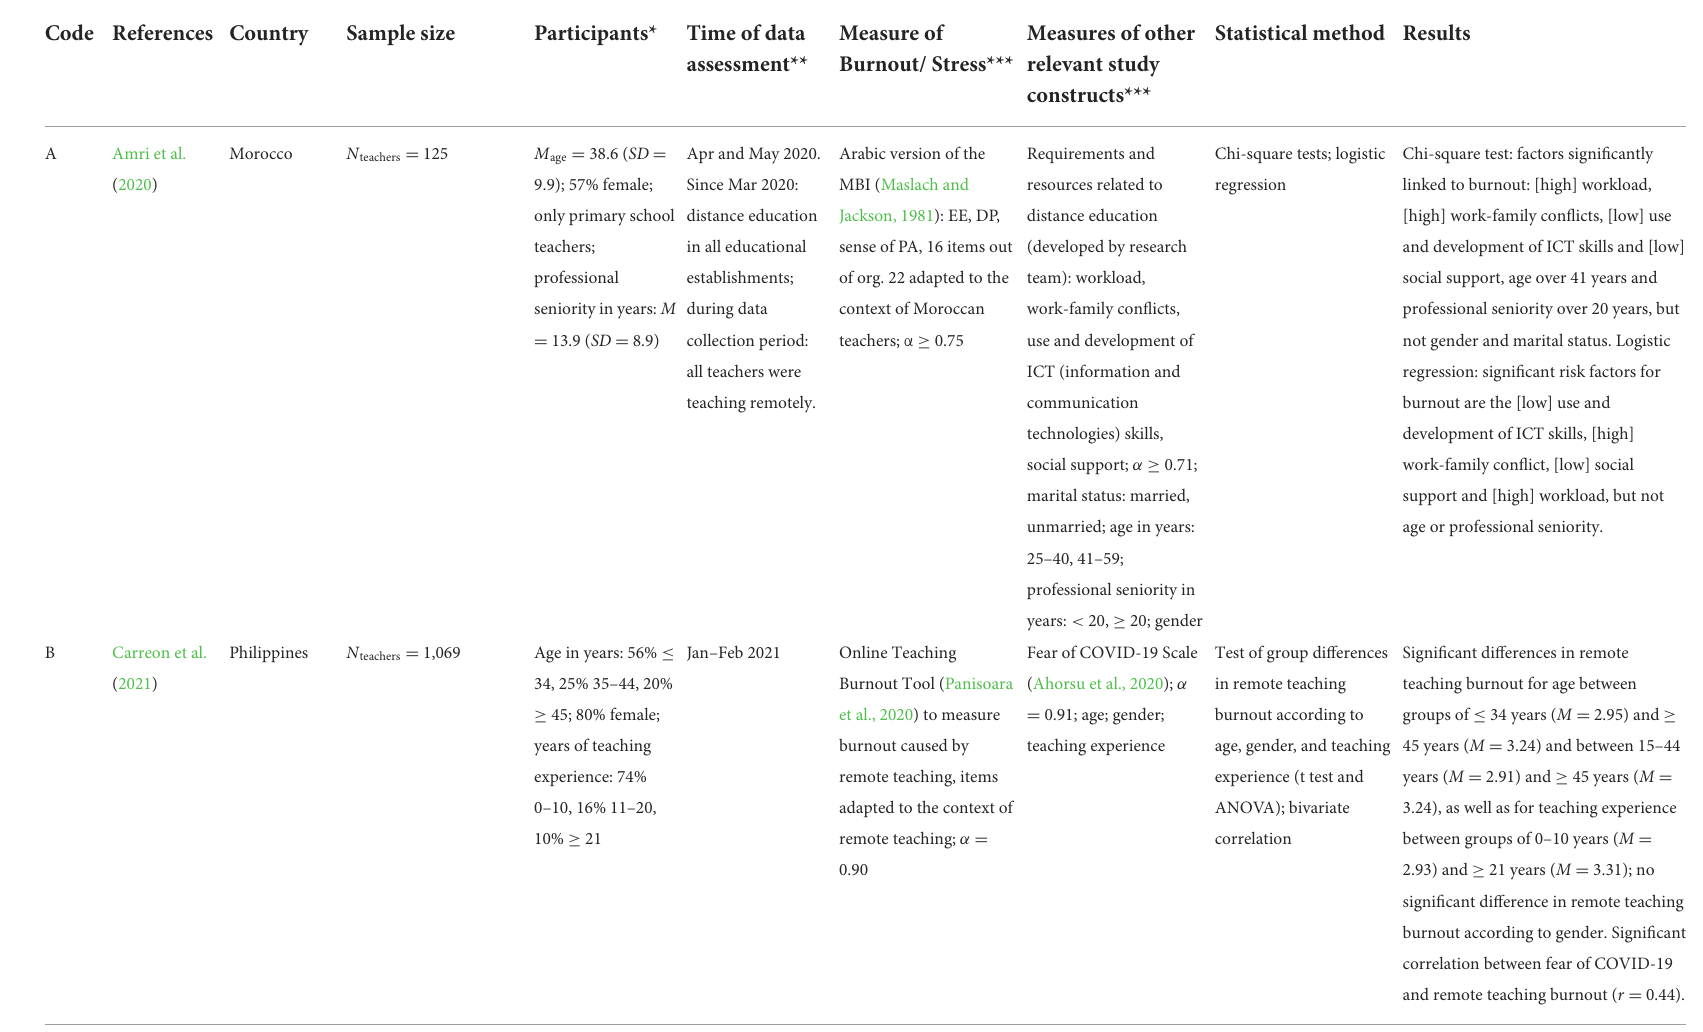
TABLE 1 Description of non-intervention studies included in the